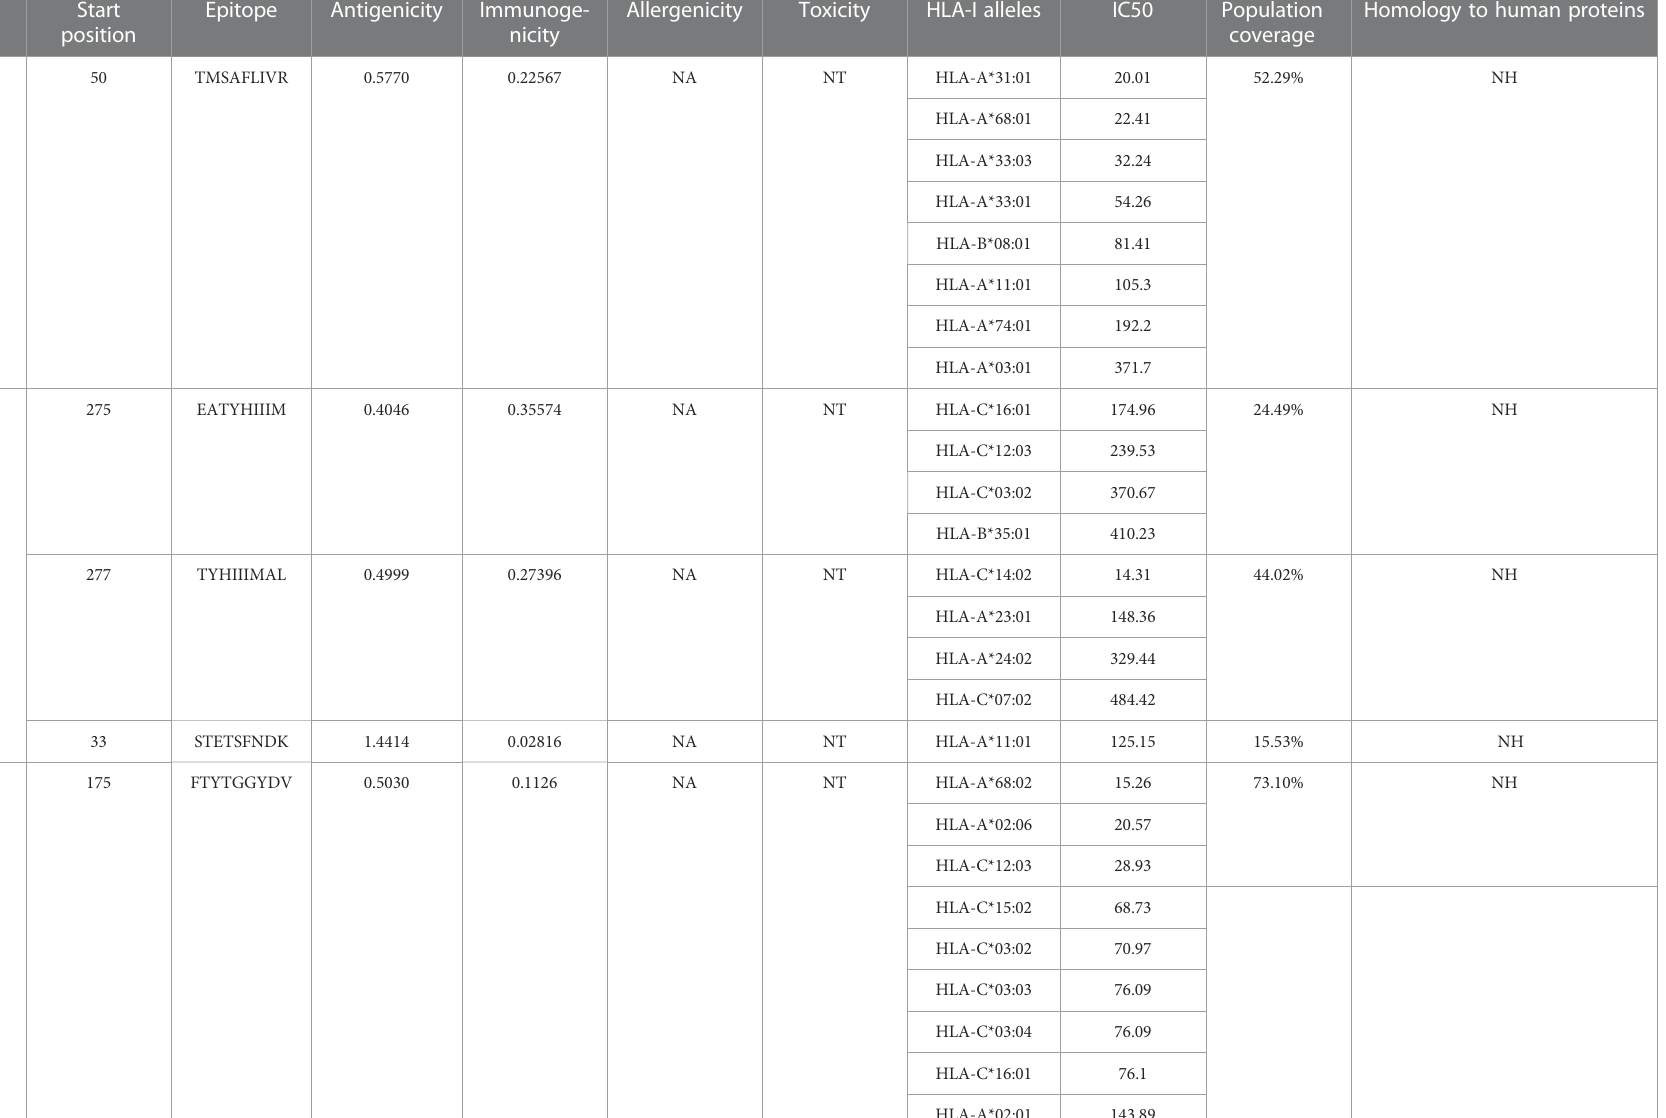
TABLE 1 List of the CTL epitopes selected for vaccine construction.